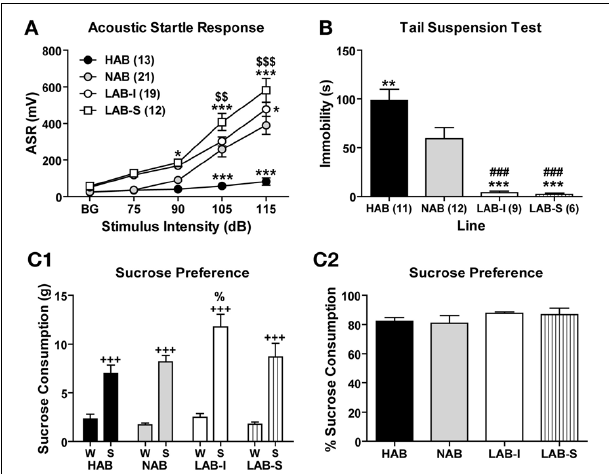
FIGURE 9 | LAB mice revealed hyperarousal and active coping styles, but did not show elevated sucrose preference. (A) Acoustic startle responses (ASR) were elicited by acoustic stimuli. LAB-I and LAB-S mice showed higher, and HAB mice lower startle responses than NAB mice. (B) In the tail suspension test, HAB mice displayed more, but LAB-I and LAB-S mice less immobility than NAB mice. Mean ± SEM. ∗∗∗ p < 0 . 001; ∗∗ p < 0 . 01; ∗ p < 0 . 05 vs . NAB. ### p < 0 . 001 vs . HAB. $$$ p < 0 . 001; $$ p < 0 . 01 vs . LAB-I (ANOVA followed by post-hoc Newman–Keuls test). In the sucrose consumption test, (C1) animals of all four lines showed a preference for 2.5% sucrose. Moreover, LAB-I mice consumed more 2.5% sucrose than the other three lines (%, p < 0 . 05). (C2) In addition, percentage of sucrose consumption did not differ between all four lines. W,